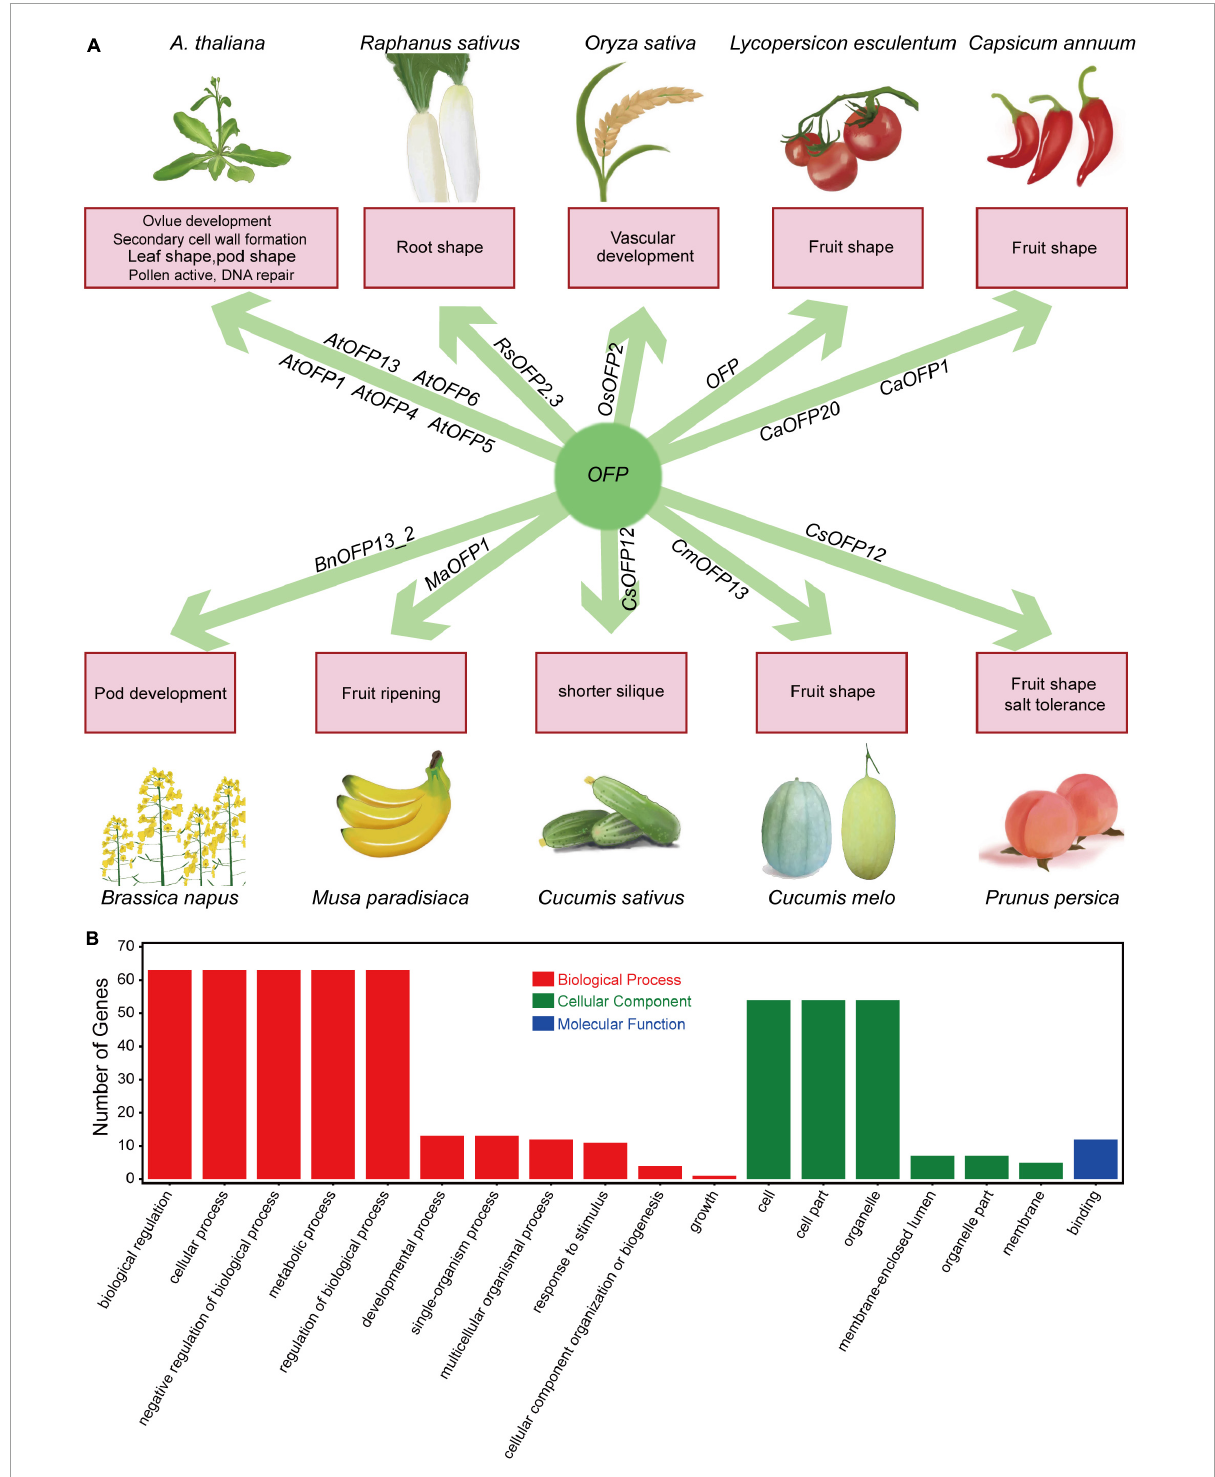
FIGURE8 Brief summary of OFP functions and GO annotations of the 67 BnOFP genes. (A) Function summary of OFPs in common crops. The crop pictures are painted. (B) GO annotations of OFP genes in B. napus . Gene numbers and annotations in biological processes, cellular components and molecular functions are shown in the